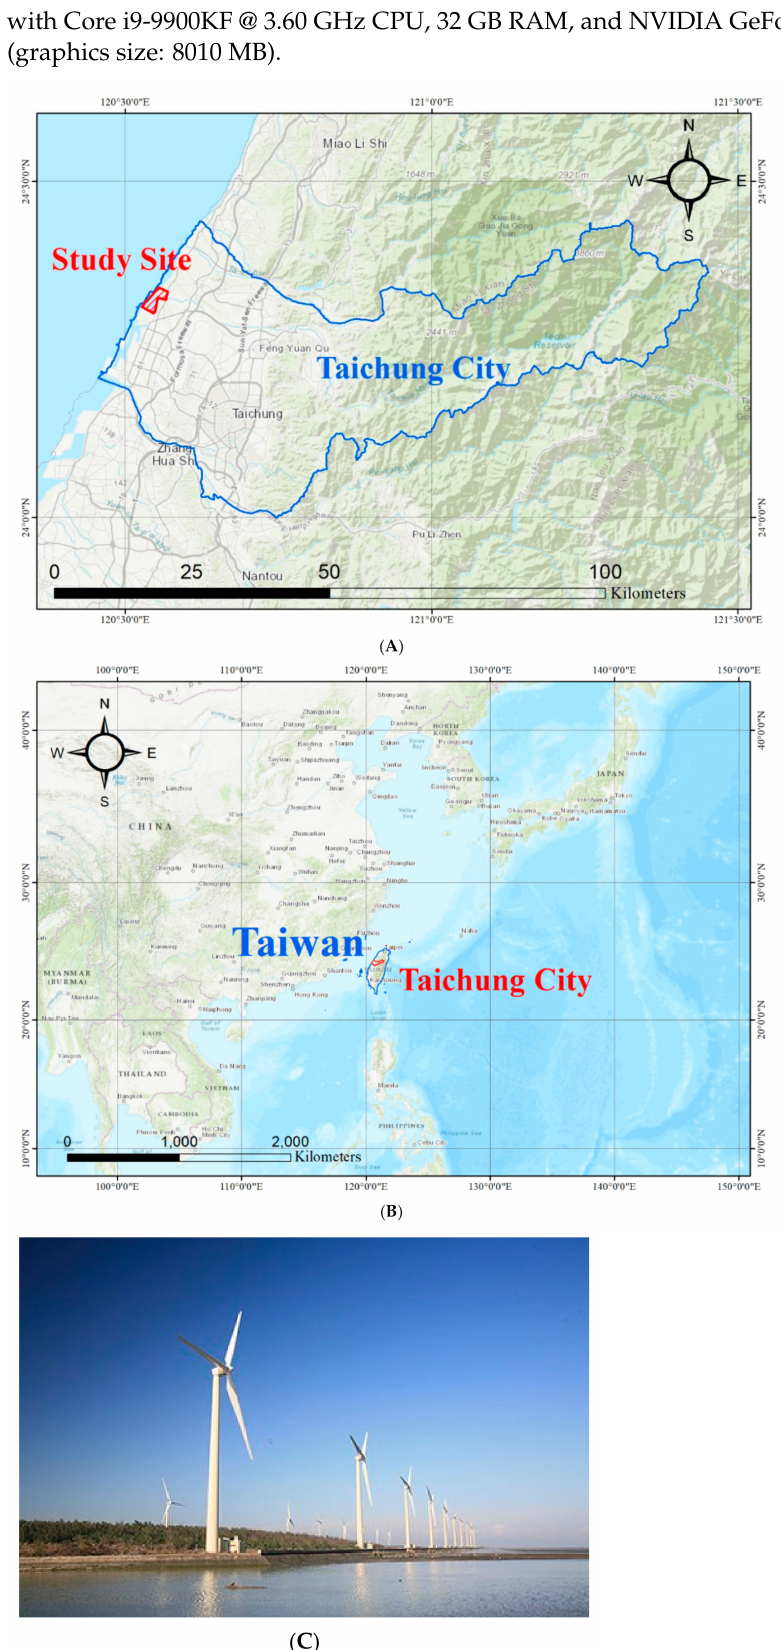
Figure 1. Study site ( A ) in Taichung, Taiwan ( B ) and onshore wind farms ( C